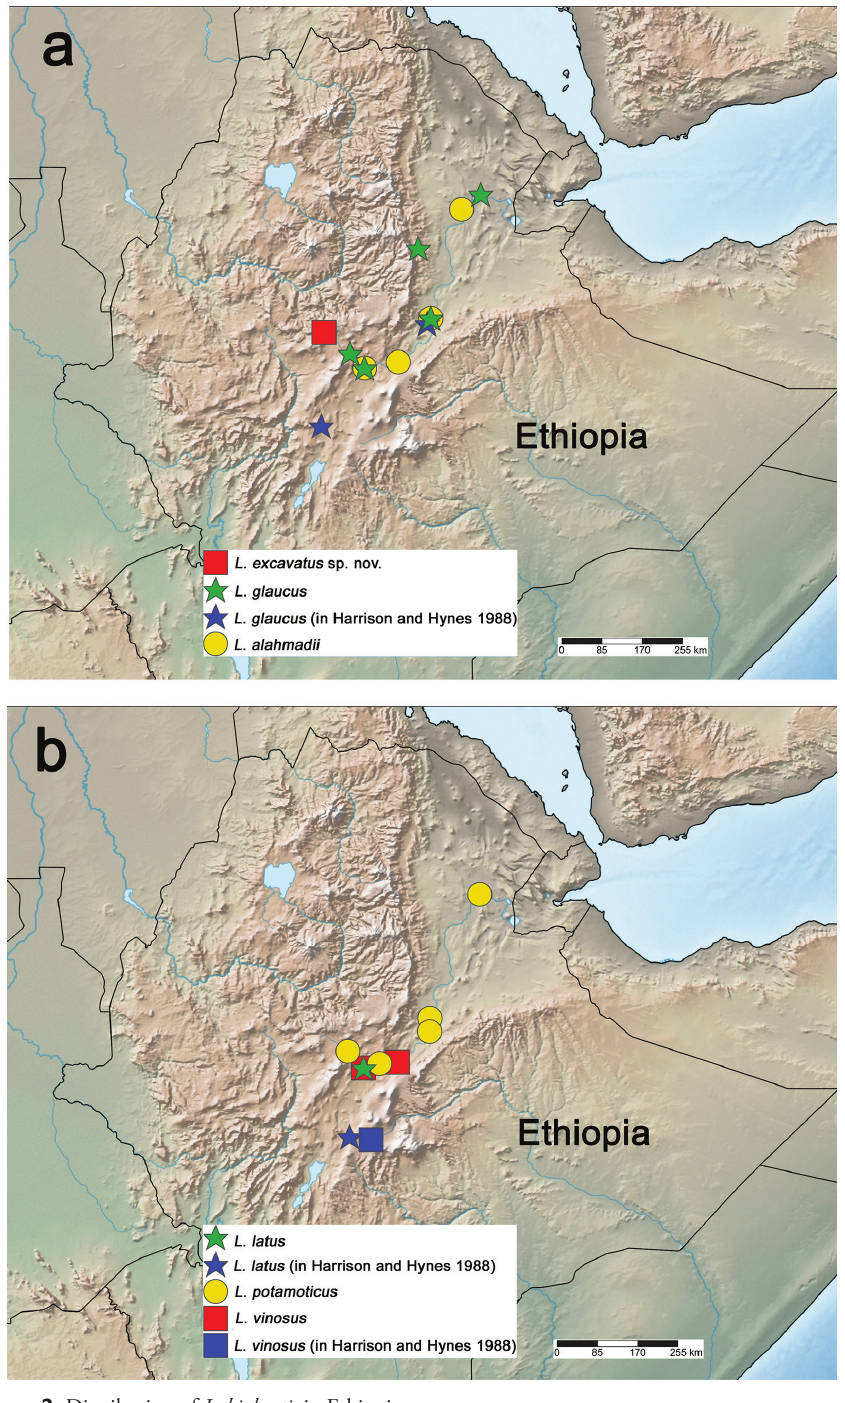
Figure 2. Distribution of Labiobaetis in